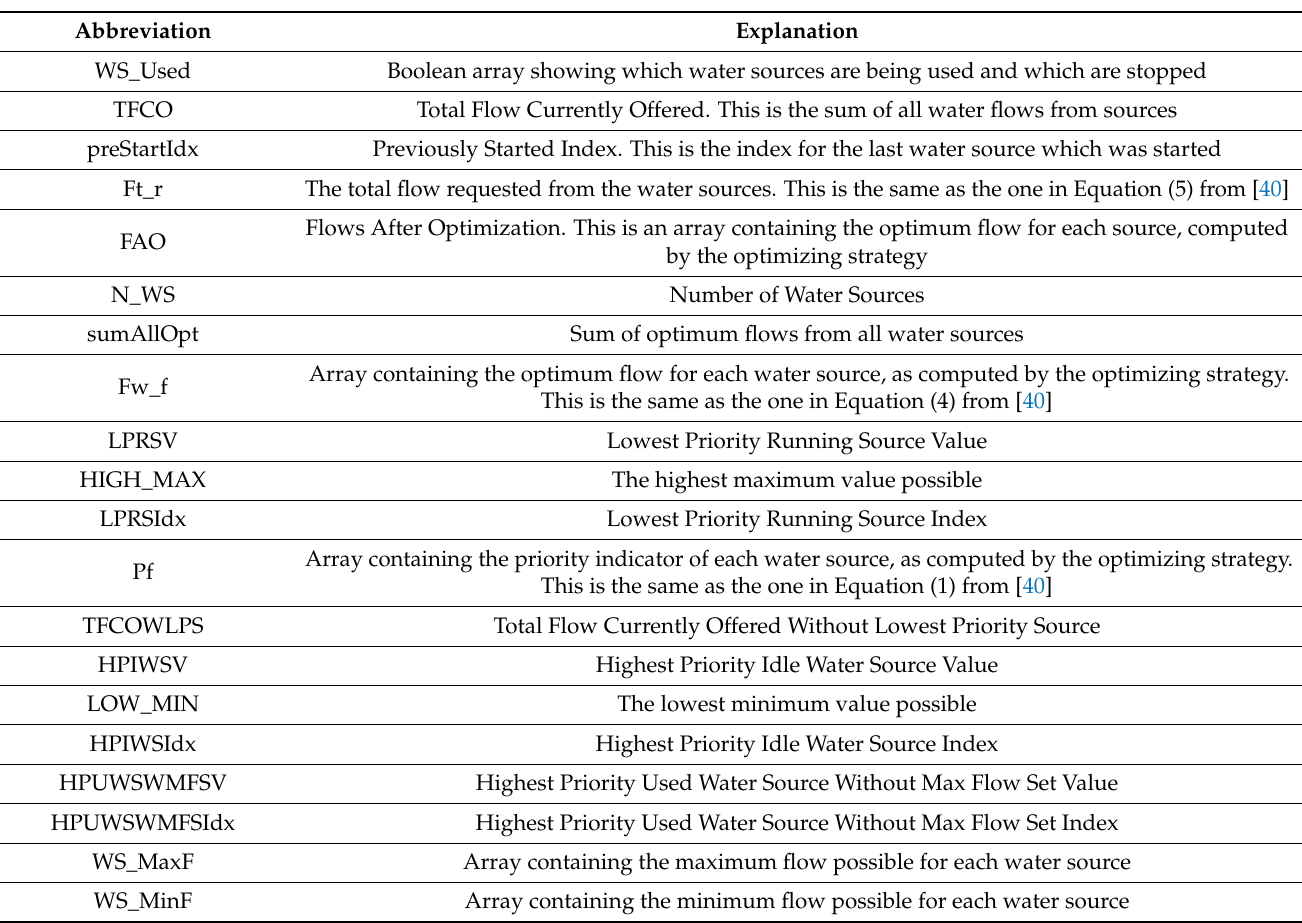
Table 1. Legend of Figure 7 and the explanations of the abbreviations used in Figure 7.